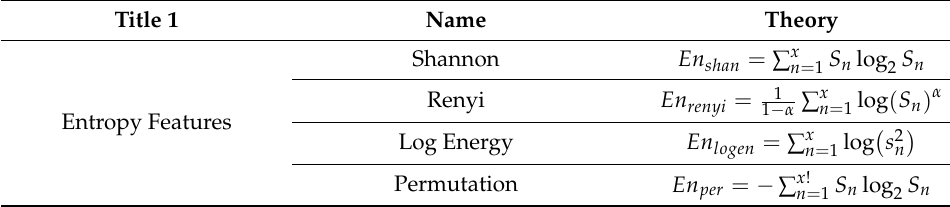
Table 2. Summary of Nonlinear Entropies Parameters Computed in this study.